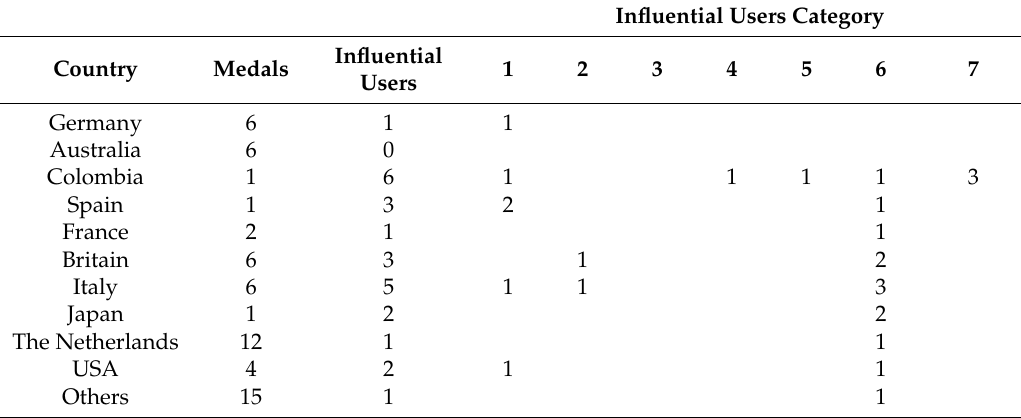
Table 9. Distribution of influential users by country and category. 2018